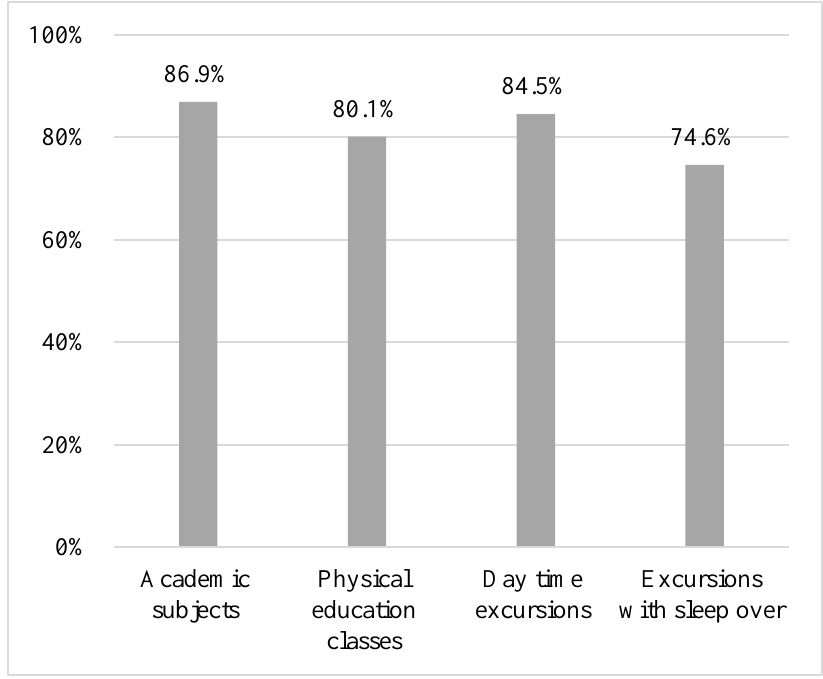
Figure 3. Proportion of participants feeling able to include students with diabetes during a school day .